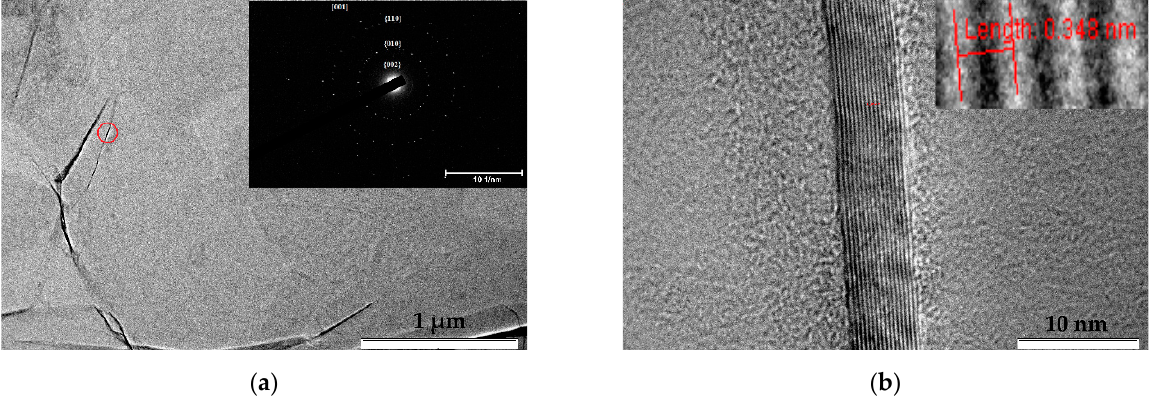
Figure 4. ( a ) TEM images of initial unirradiated MLG. On the inset the diffraction pattern; ( b ) the edge of a folded region. On the inset enlarged image.